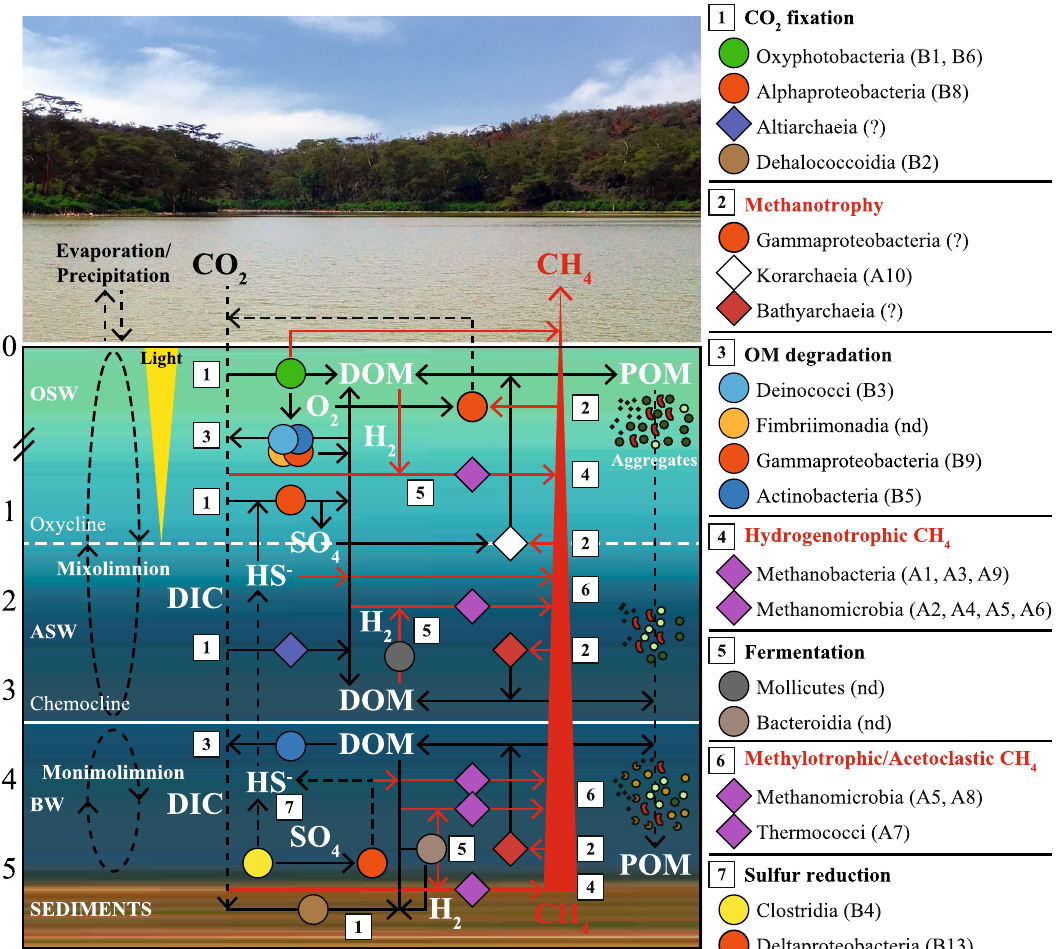
Fig. 7 Conceptual model of major C-cycle related processes. Box 1-7 processes mediated by key abundant archaeal and bacterial classes (diamonds and circles) as detected by amplicon sequencing in samples from Lake Sonachi. Dominant genera are ordered by letters and numbers (Archaea = A1, A2, A3, etc.; Bacteria = B1, B2, B3, etc.). Solid red arrows refer to processes directly involved in methane metabolism. Solid red arrows refer to processes involving dissolved solutes. Dashed black arrows refer to crossing-chemocline release of gases (e.g., CO 2 , H 2 S) and sedimentation of POM and microbial aggregates. Functional assignments are based on putative metabolic activities of known prokaryotic taxa retrieved at the biogeochemical conditions across the lake